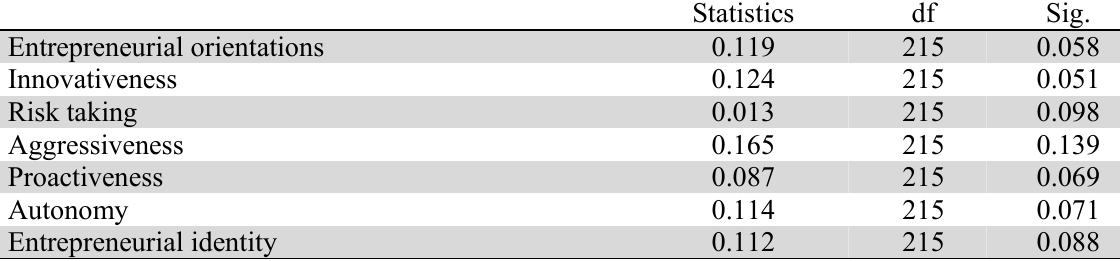
Results of Kolmogorov - Smirnov test